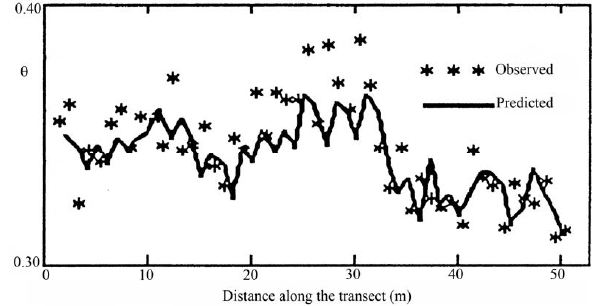
Fig. 11. Water content θ 3 observed and estimated with the first of Eq.